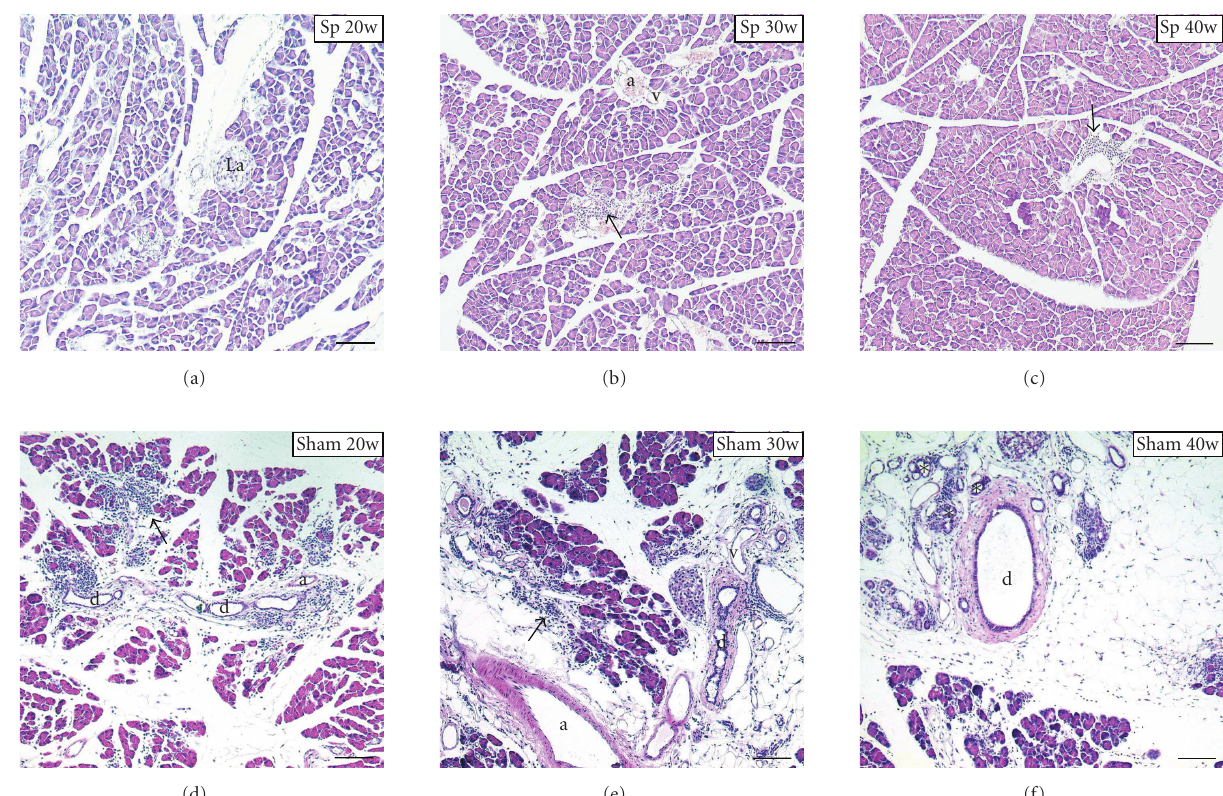
Figure 2: Histopathological analysis of e ff ects of splenectomy (sp) on pancreatitis developing in aly/aly mice at the ages of 20, 30, and 40 weeks old, respectively. Sham 20 w, 30w, and 40 w indicated sham-group mice at the ages of 20, 30, and 40 weeks old, respectively. Arrows, indicating lymphoid cell infiltration and ∗ indicating some pancreatic ducts of proliferation and regeneration. a, artery; d, pancreatic duct; La, islet of Langerhans; v, vein. Scale bars: 200 μ